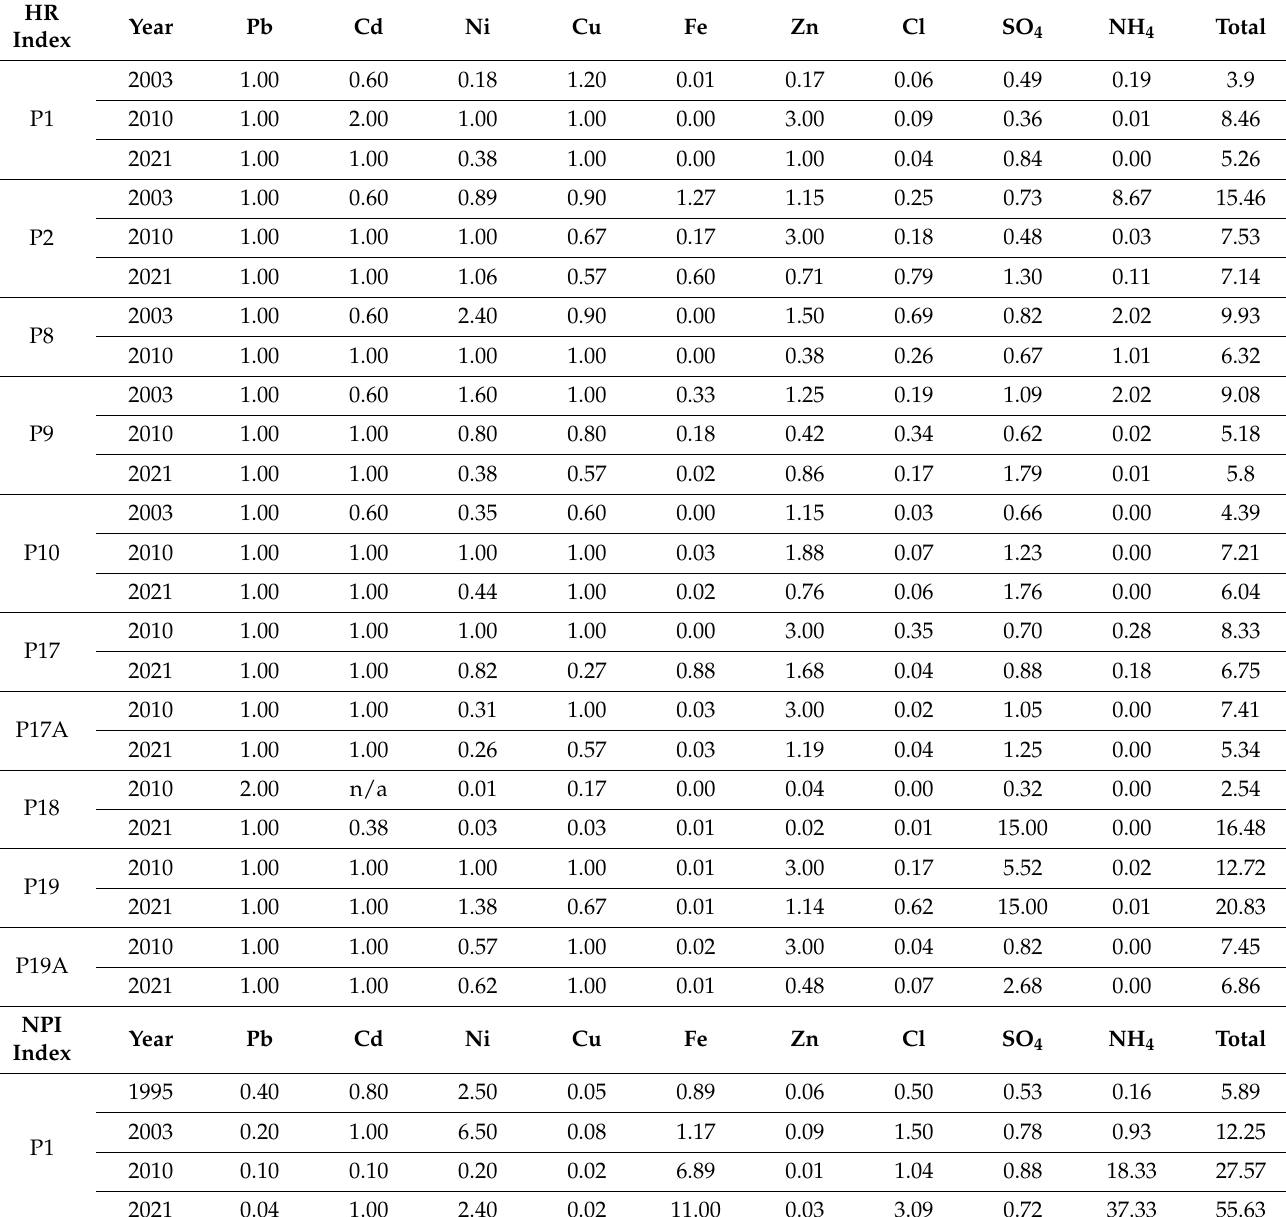
Table A1. Partial values of HR, NPI and EF